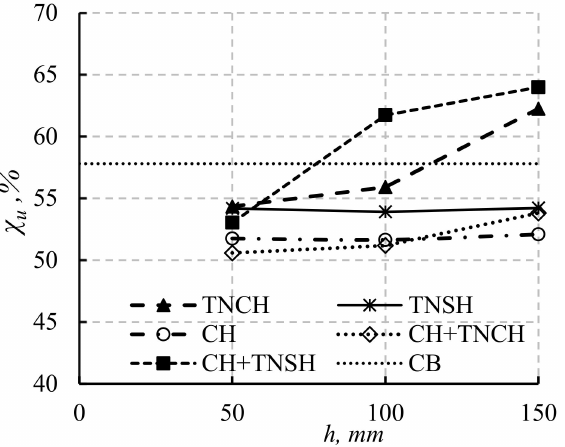
Figure 16. The effect of beam length on the failure loads of solid and hollow beams with openings in different positions.